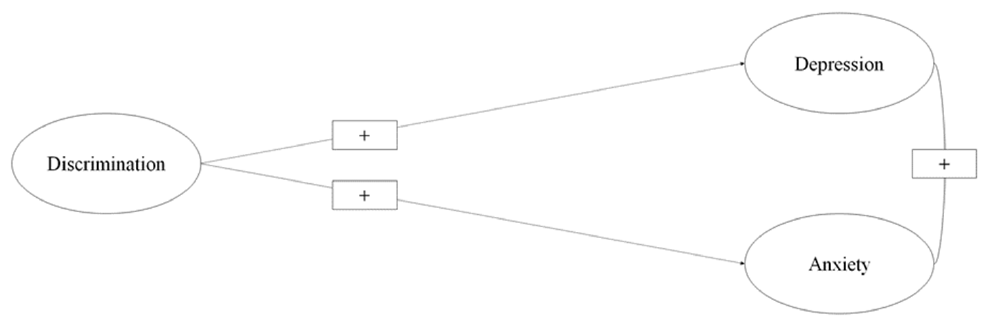
Figure 1. Effect of discrimination on depression and anxiety.